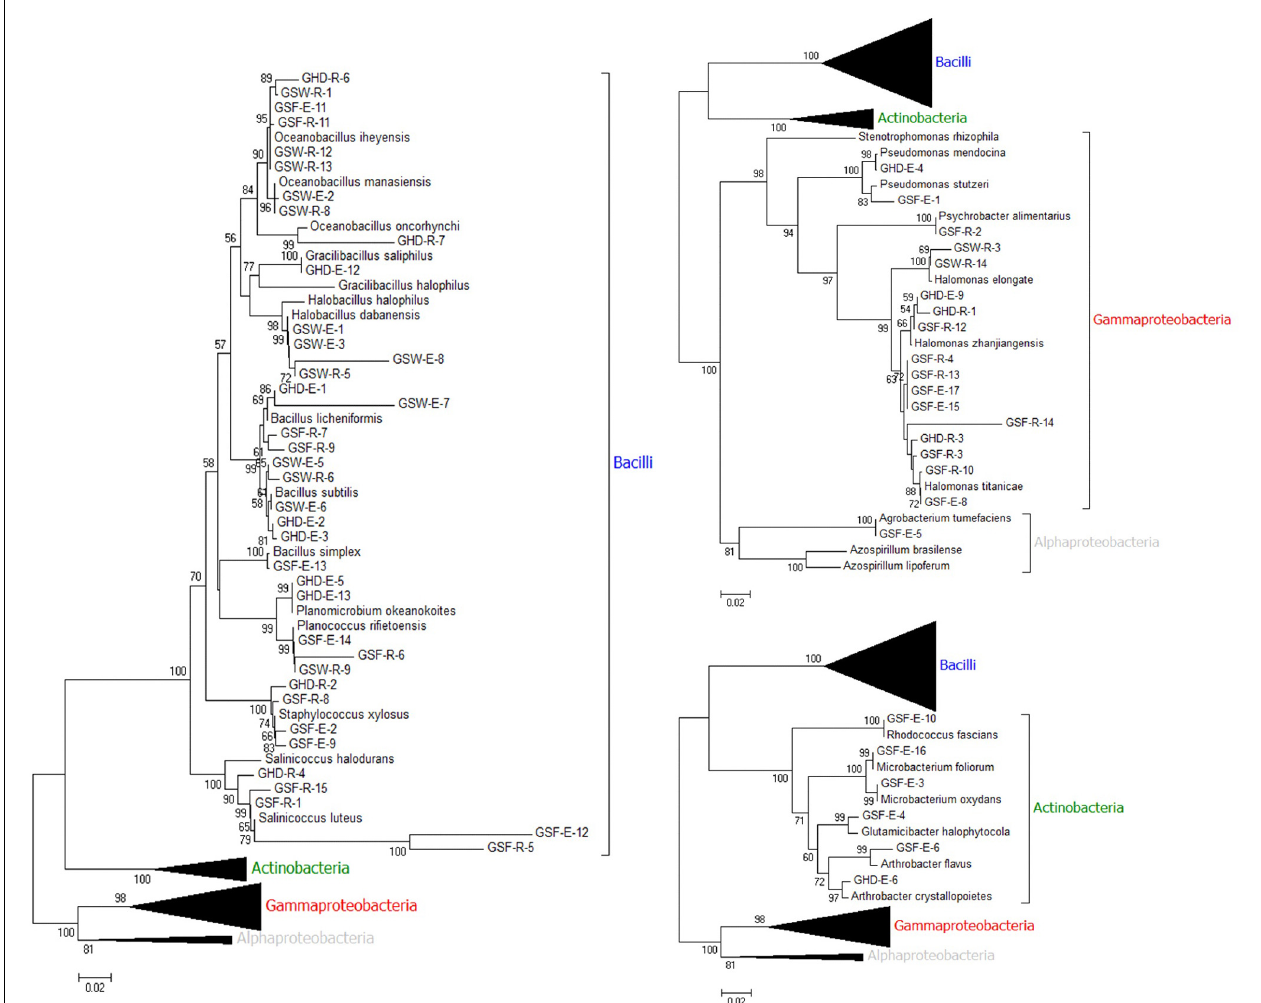
FIGURE 1 | Phylogenetic tree constructed by using neighbor-joining analysis between 62 bacterial isolates [endophytic (E) and rhizospheric (R) and grouped based on class] collected from three locations [Ghor Haditha (GHD), Ghor Safi (GSF), and Ghor Sweimeh (GSW)] nearby the Dead Sea region based on 16S rDNA sequences and sequences from selected bacteria reference isolates (GenBank accession number for the collected isolates and reference strains are given in Supplementary Table S5 ). Bootstrap values ( > 50) are represented by numbers at the nodes based on 10000 replications.